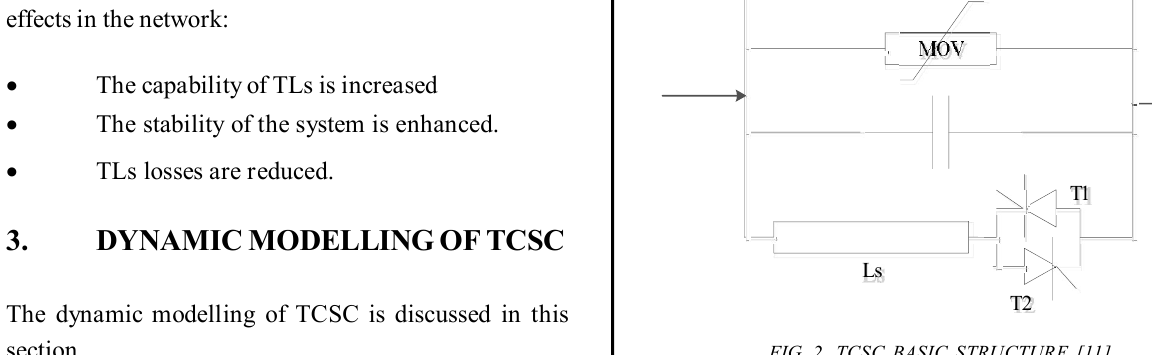
FIG. 2. TCSC BASIC STRUCTURE